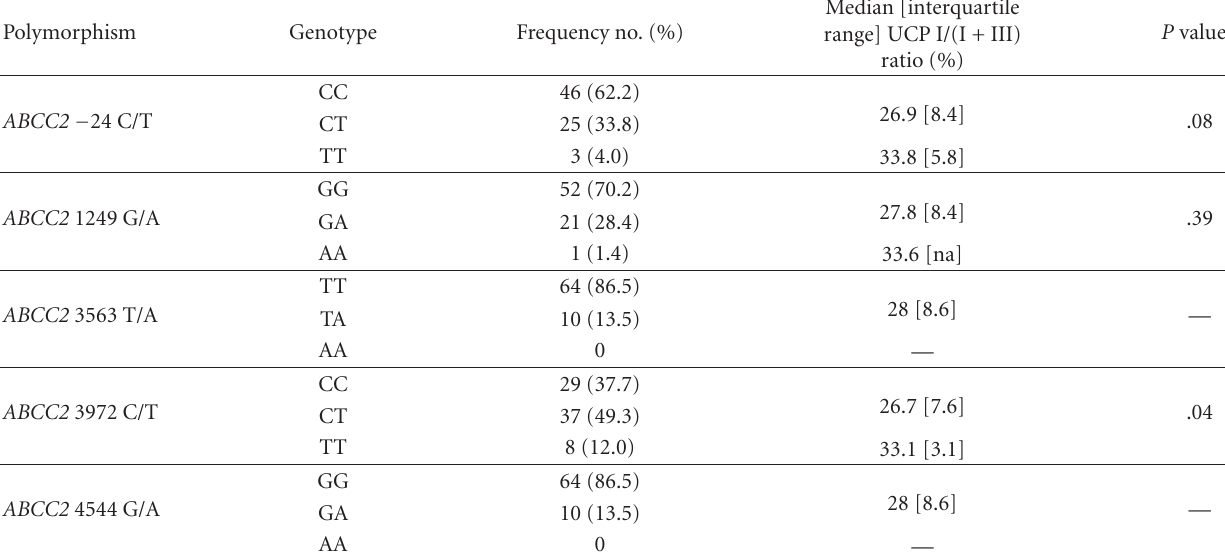
∗ Wild-type allele carriers versus homozygous variant.